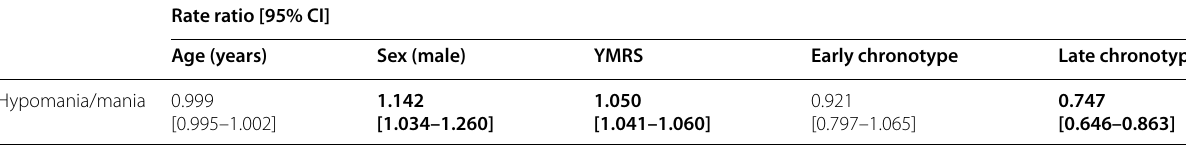
Females and normal chronotype were used as reference groups Bold RRs are significant at p < 0.01